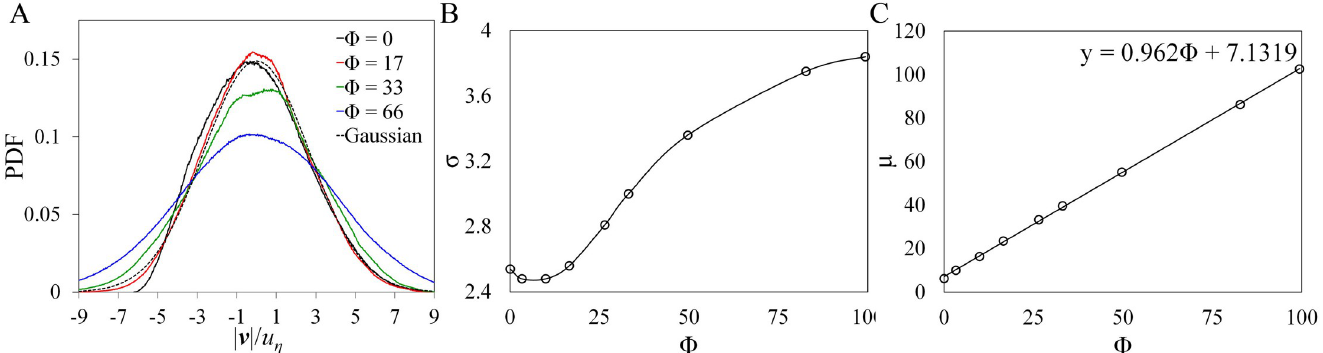
Fig 4. PDF of microswimmer speed when Re λ = 59. All values are subtracted with the mean such that the distributions are centered at zero. (B) and (C) are plots of the standard deviation σ and mean μ versus the swimming speed, respectively.